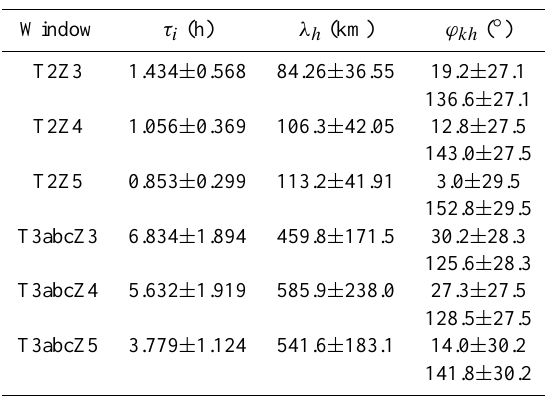
Table 6a. Mean ± standard deviation of characteristic intrinsic wave period τ i , horizontal wavelength λ h , and azimuth angle of horizon- tal wave vector ϕ kh of the atmospheric gravity wave packets with upward group velocity. These parameters were obtained by disper- sion equations assuming BV-period equal to 5min. The events were from winter data set. Note that the two values of ϕ kh are symmetric with respect to the azimuth angle (77 . 9 ◦ ) of the mean wind velocity vector.